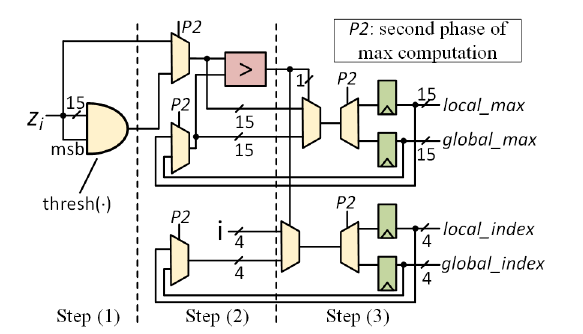
Figure 7: Hardware design of the unmasked output layer. z i represents confidence score of the i th node in the output